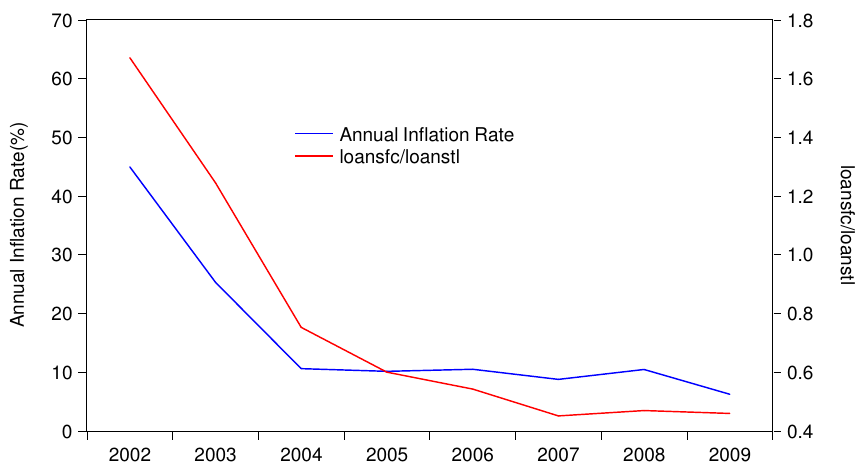
Figure 4. Inflation vs . FC to TLloan